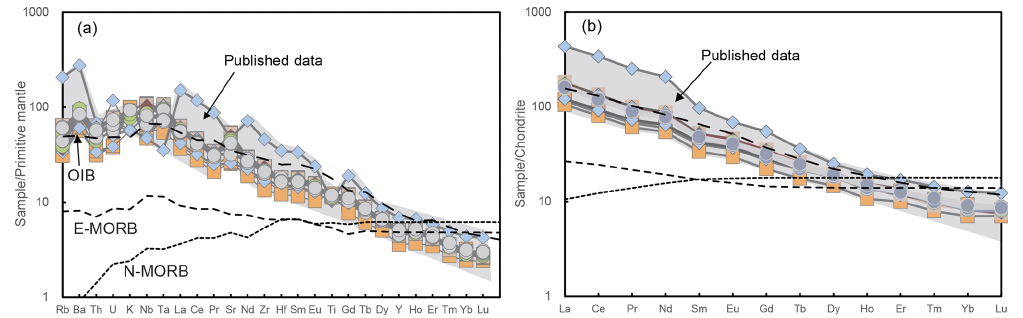
Figure 7. (a) Primitive-mantle-normalized multi-element diagrams (normalization values are after Sun and McDonough, 1989). (b) Chondrite-normalized REE patterns of the WVF volcanic rocks (normalization values are after Sun and McDonough, 1989). The values of OIB (ocean island basalt), N-MORB (normalized mid-ocean ridge basalt) and E-MORB (enriched mid-ocean ridge basalt) from Sun and McDonough (1989) are shown by the dashed lines. Symbols and fields are the same as in Fig. 6.